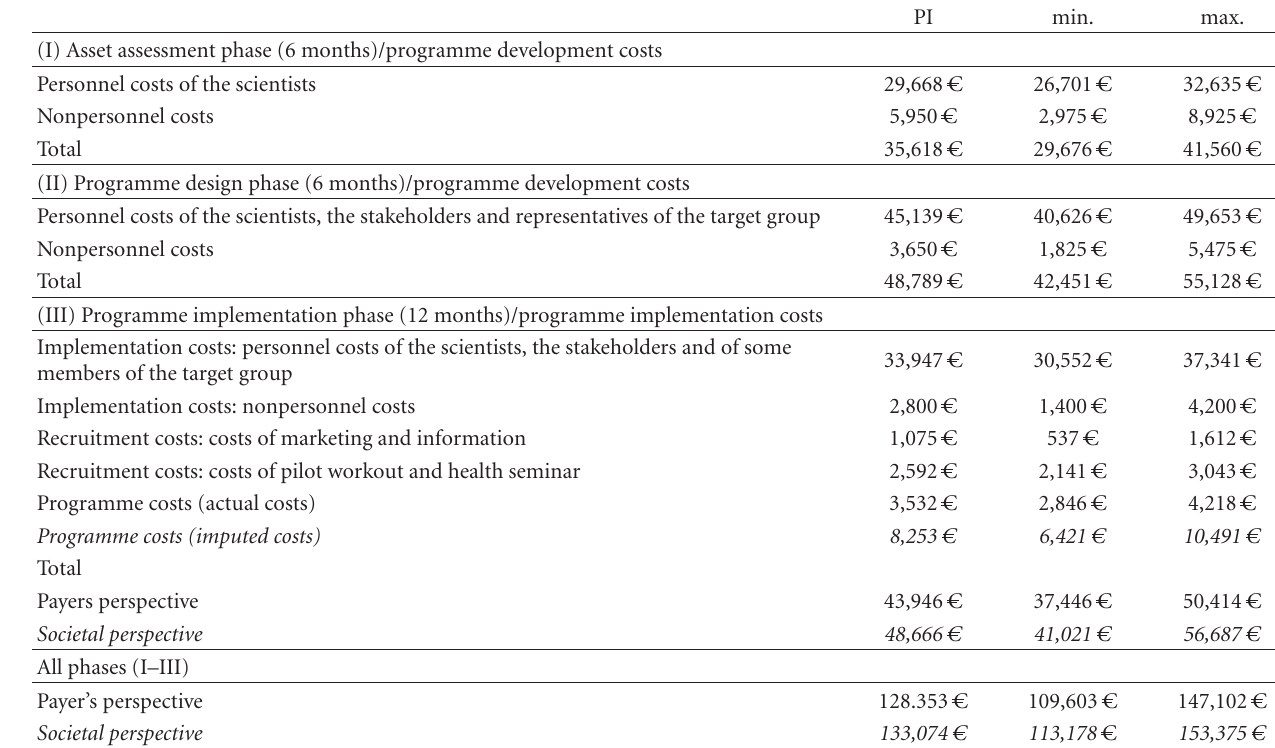
Table 6: Total project costs by project phases and input-oriented cost categories.